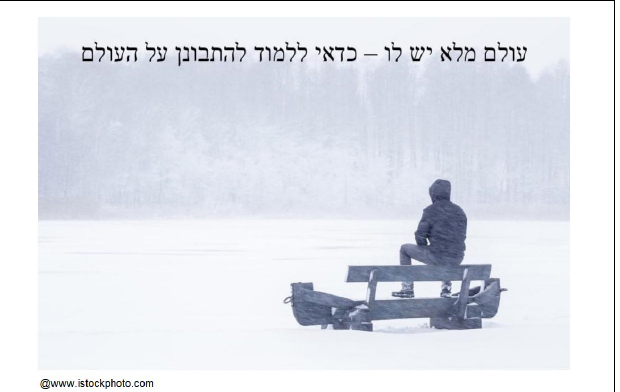
FIGURE 9 | Yossi’s chosen photograph and title: “He has a whole world—it is worth learning to observe the world.”